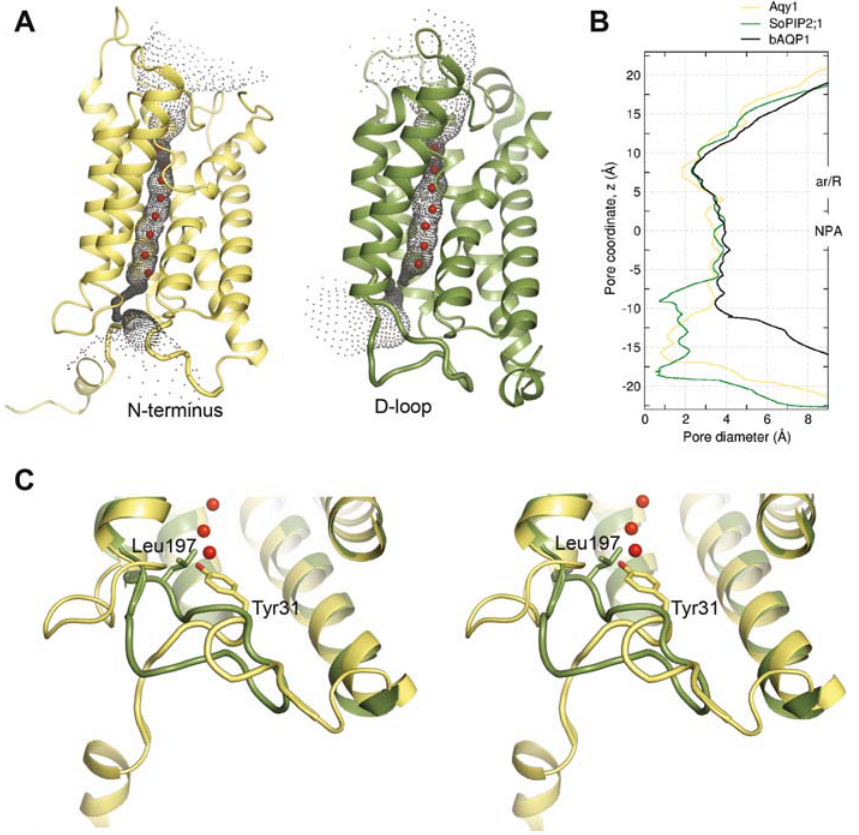
Figure 7. Structure comparisons of closed aquaporins from P.pastoris and spinach. (A) Comparison of the Aqy1 from P. pastoris (left panel) with the spinach aquaporin SoPIP2;1 (right panel) shown as HOLE representation. The pore is occluded by the N terminus in Aqy1, and by loop D in SoPIP2;1. (B) The pore diameter of closed Aqy1 (yellow), closed SoPIP2;1 (green), and constitutively open bAQP1 (black) structures calculated with program HOLE. (C) Stereo-view of the superposition of SoPIP2;1 (green) onto Aqy1 (yellow). Residues identified in the narrowest parts of the pores of the respective aquaporin are shown in stick representation.